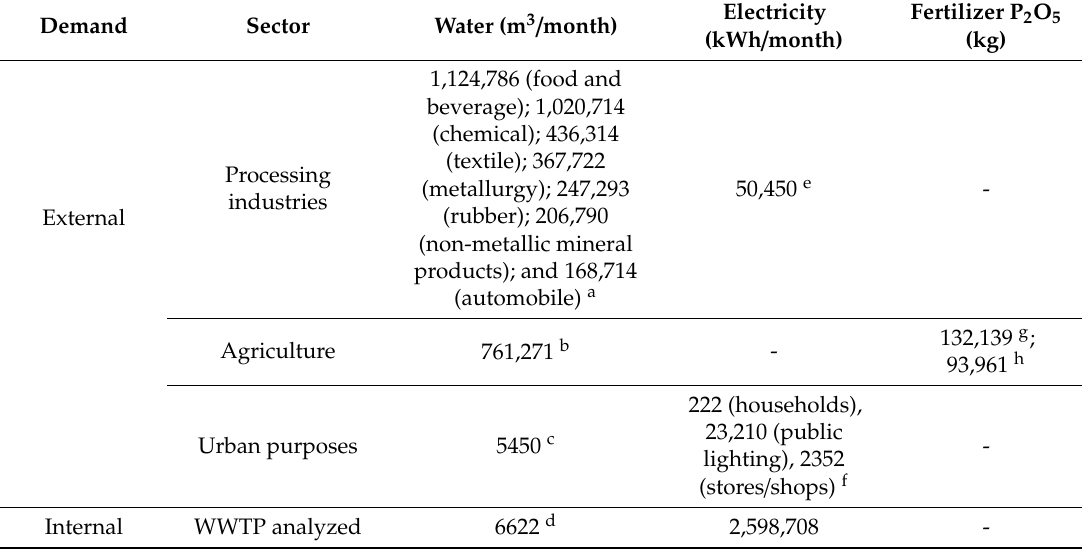
Table 5. Estimated demand for the wastewater treatment plant and nearby locations for